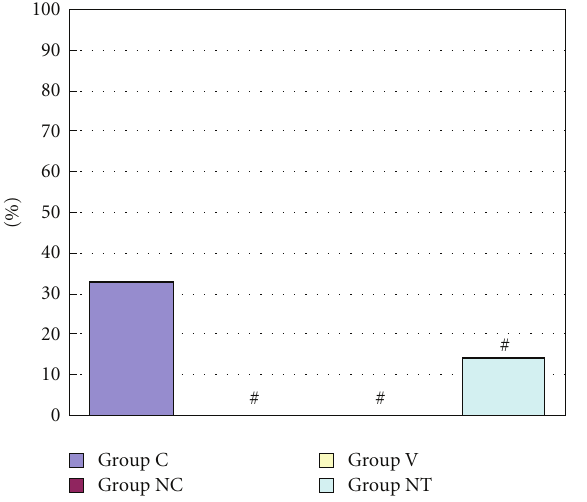
Figure 4: The figure shows incidence of arrhythmias during myocardial ischemia. Group C: a control group. Group NC: a nicardipine group. Group V: a verapamil group. Group NT: a nitroglycerin group. # Significantly di ff erent ( P < . 05) from Group C (mean ± S.D.).